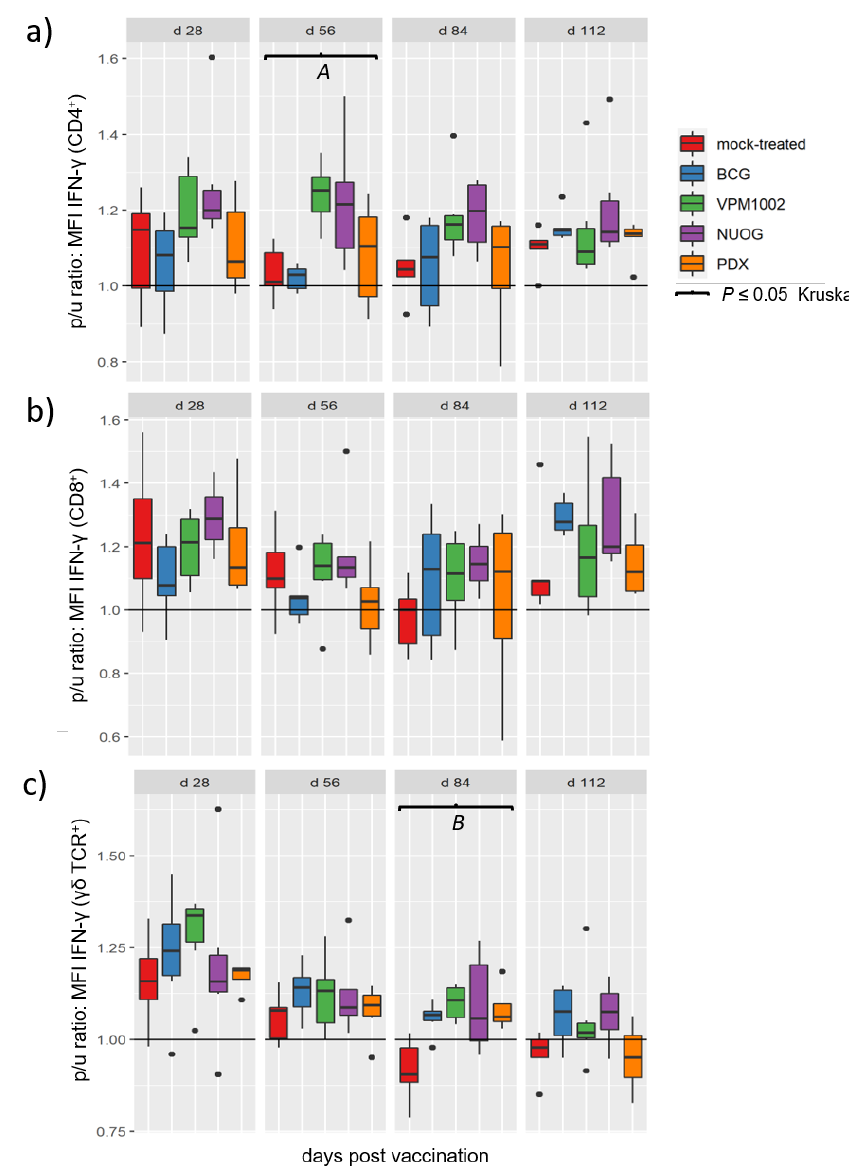
Figure 8. Relative amounts of intracellular IFN- γ in T cell subsets after in vitro stimulation with bPPD of goats vaccinated with either BCG, VPM1002, NUOG, PDX, or mock-treated. Boxplots represent values of the p/u ratio of the median fluorescence intensity (MFI) for the detection of IFN- γ within the population of ( a ) CD4 + T cells, ( b ) CD8 + T cells, and ( c ) γδ T cells. ( A ) Values for the VPM1002- and NUOG-vaccinated groups significantly differed from the values of the mock- and the BCG-vaccinated groups. ( B ) Values of all vaccinated groups differed from values of the mock-treated group.